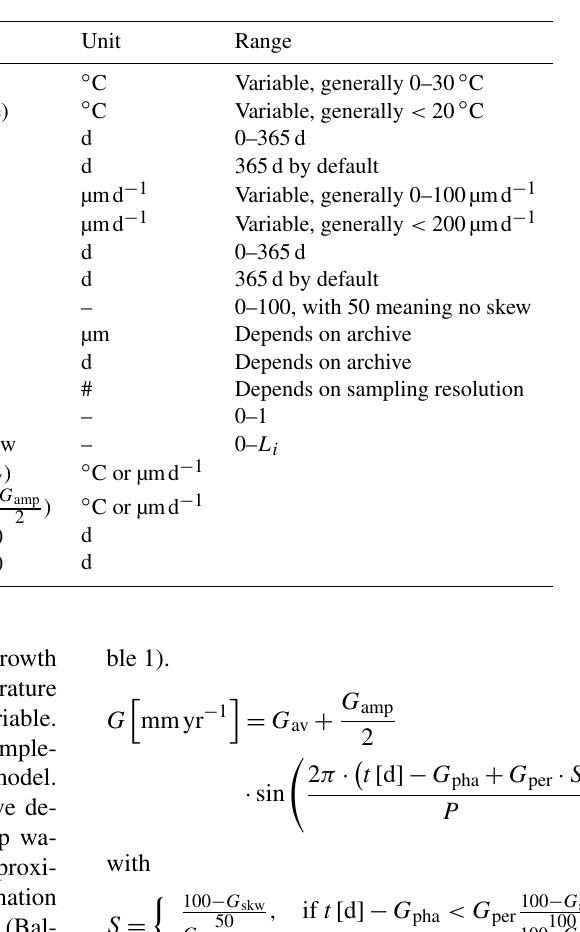
Table 1. Overview of model parameters.